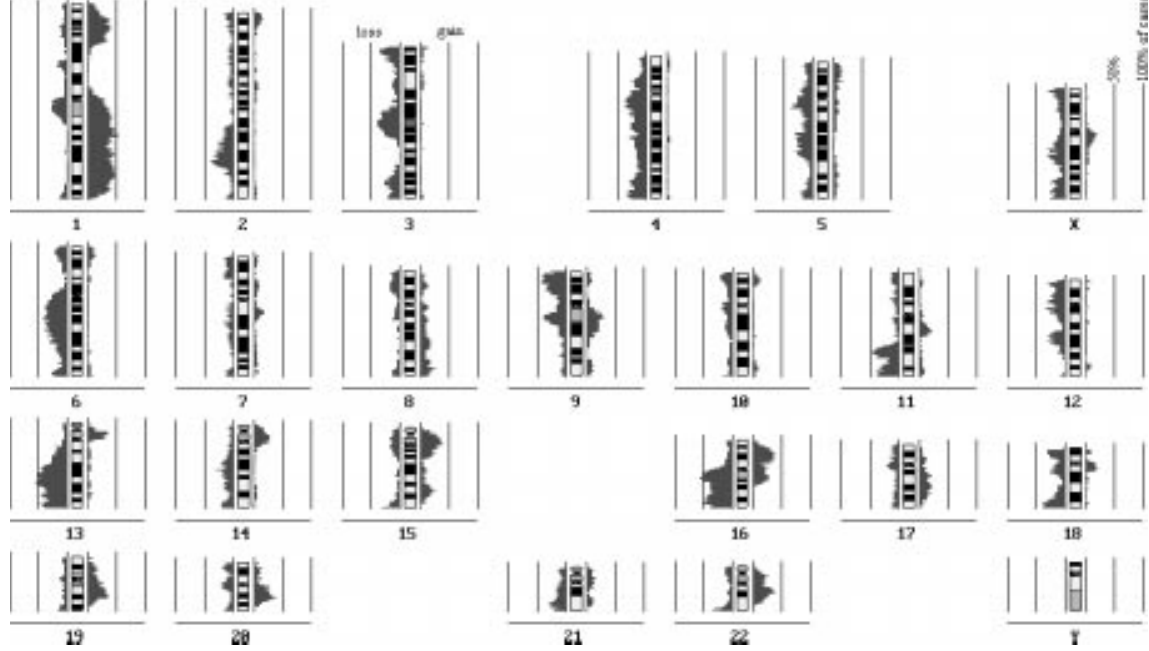
Fig. 4. Histogram of the CGH result of 23 peridiploid breast cancers. The gray areas besides the chromosomes represent the percentage of cases with imbalances in the chromosomal region. Losses are reflected on the left side, gains on the right side of the chromosome ideograms. Significance level of 95% for gains or losses in the Student’s t -test.